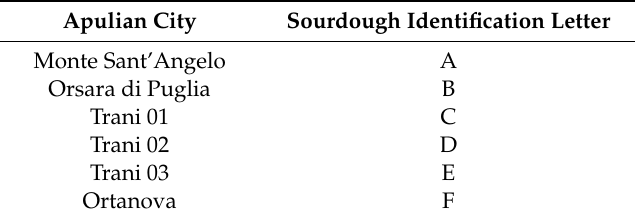
Table 1. Apulian sourdough samples collected in this